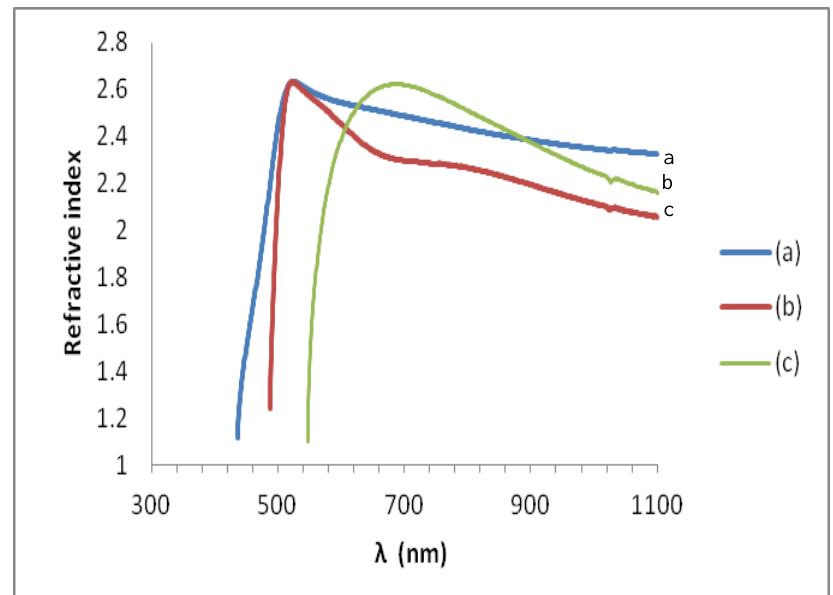
Fig.5: Refractive index of the films for ; (a) one deposition (b) double deposition and (c) after triple